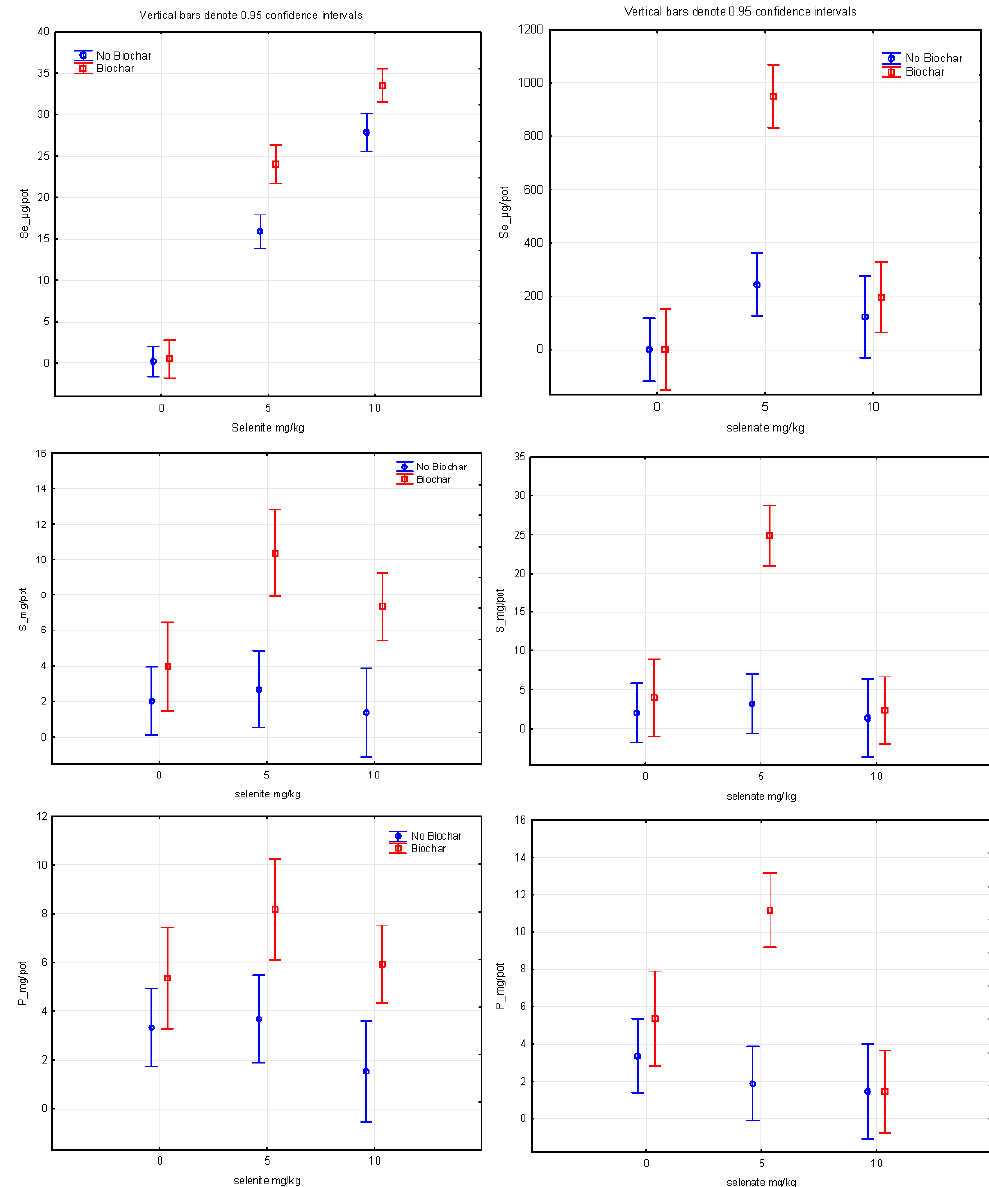
Figure 2. Selenium, sulfur, and phosphorus total uptake by lettuce plants.